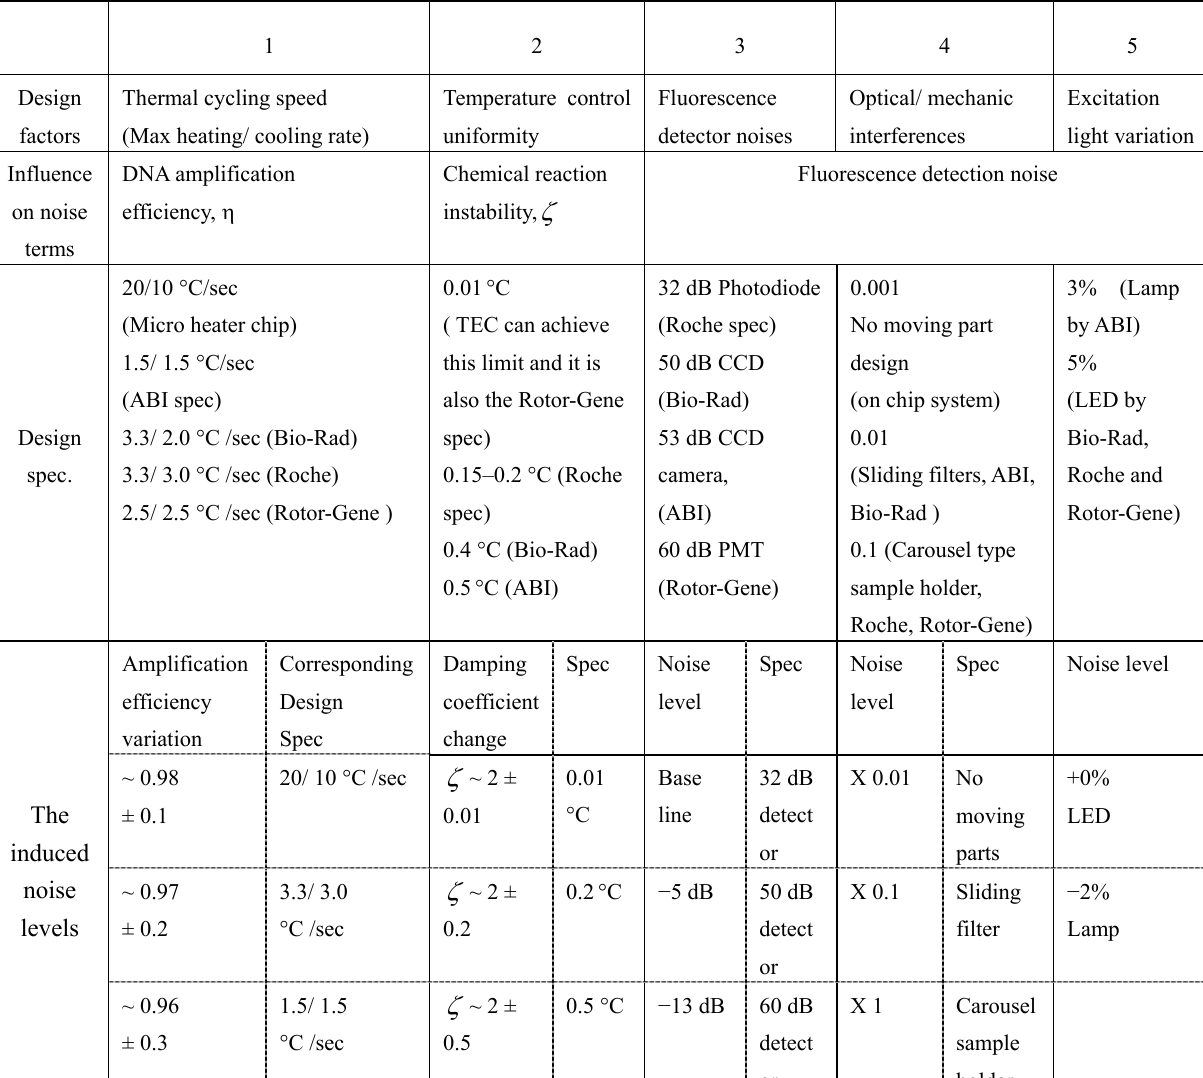
Table 2. Real-time PCR machine design factors